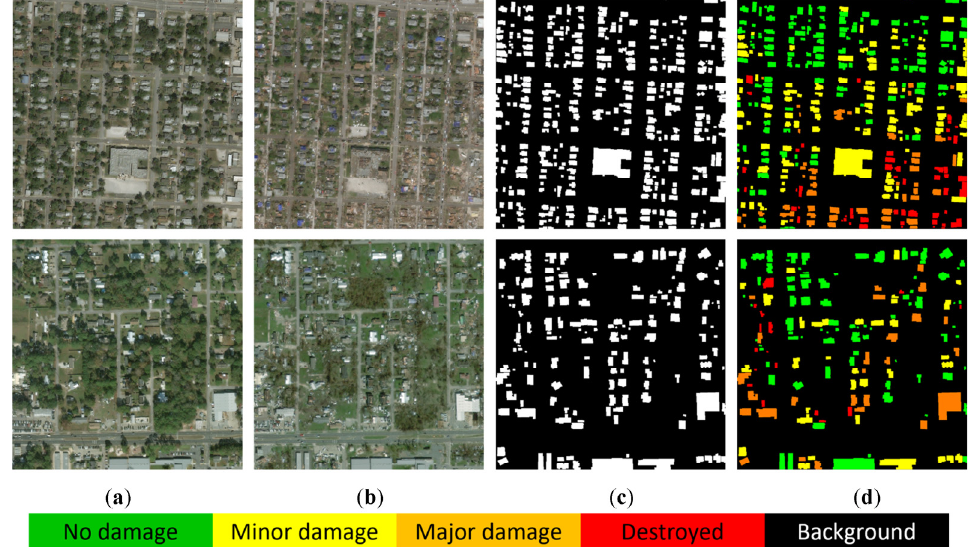
Table 1. Overview information of datasets in the study.